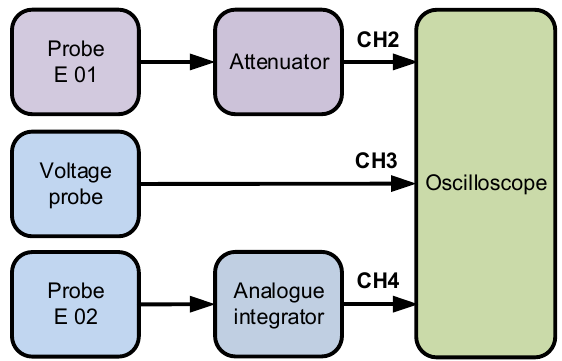
Figure 3. Laboratory setup for the electric field measurement. Probes E01 and E02—Montena SGE3- 5G; Voltage probe—Tektronix P5100A; Attenuator—Montena attenuators: 10, 20, 30 dB, Analogue integrator: Montena ITR1-2U; Oscilloscope—LeCroy Waverunner 940Zi.